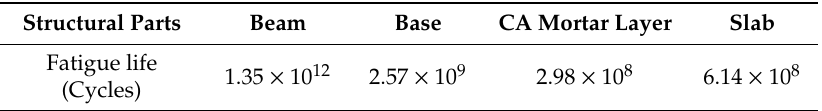
Table 5. Fatigue life of structural